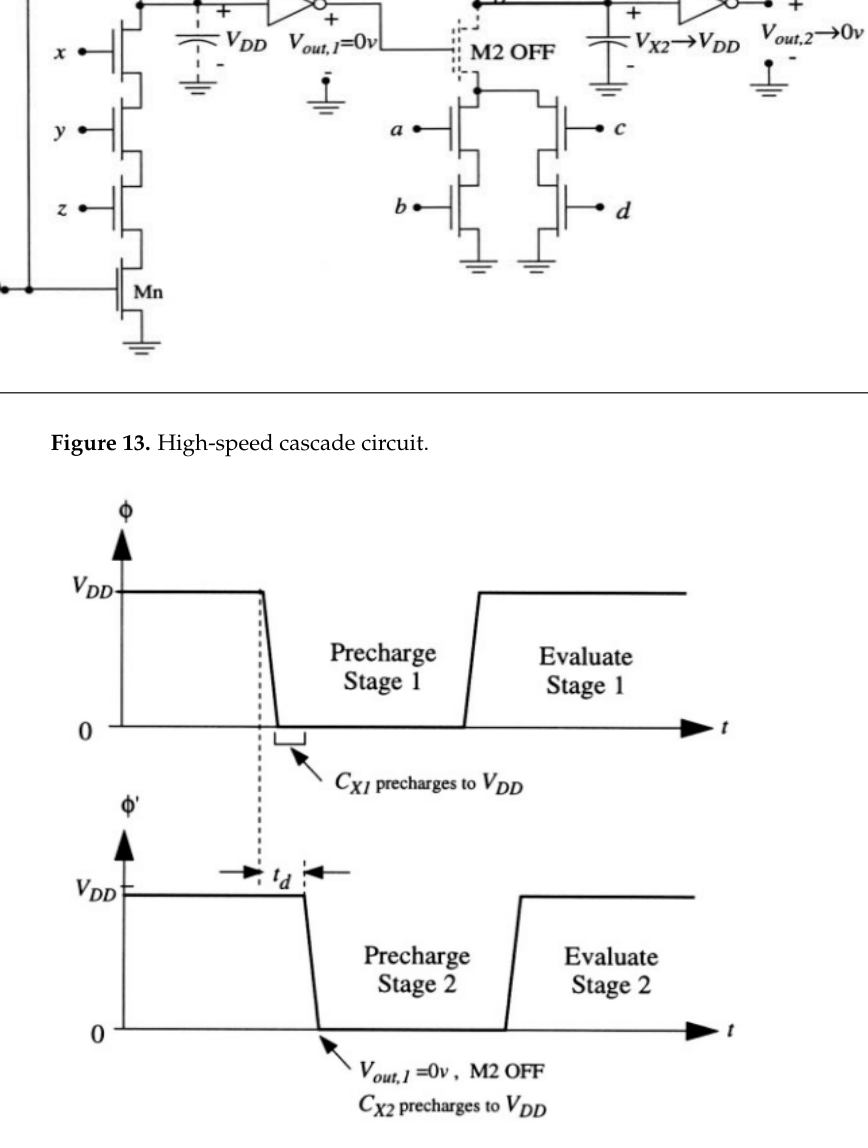
Figure 14. Timing requirement high-speed cascade circuit. Table 3. Comparison of various types of domino logic circuits.